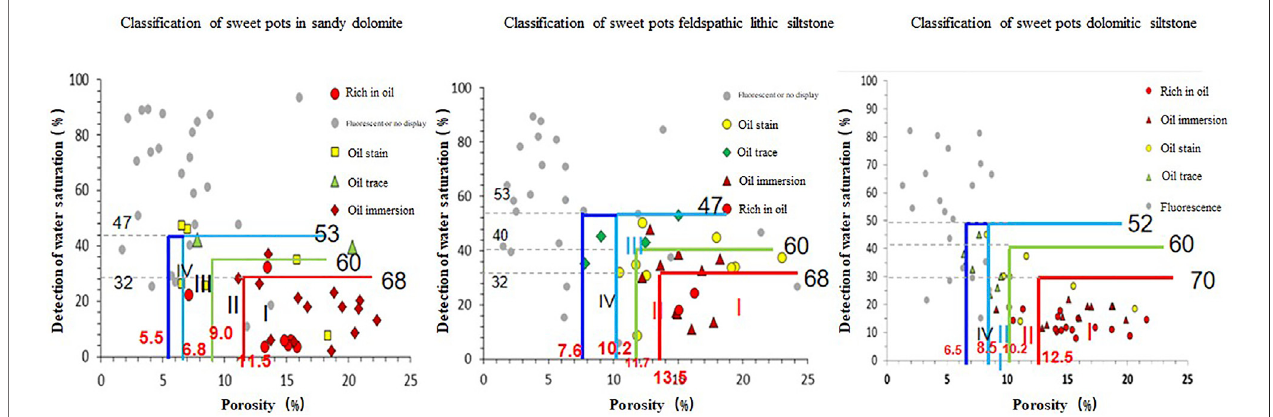
FIGURE 10 | Different lithology grading chart of the upper sweet spots in the Lucaogou Formation of the Jimsar